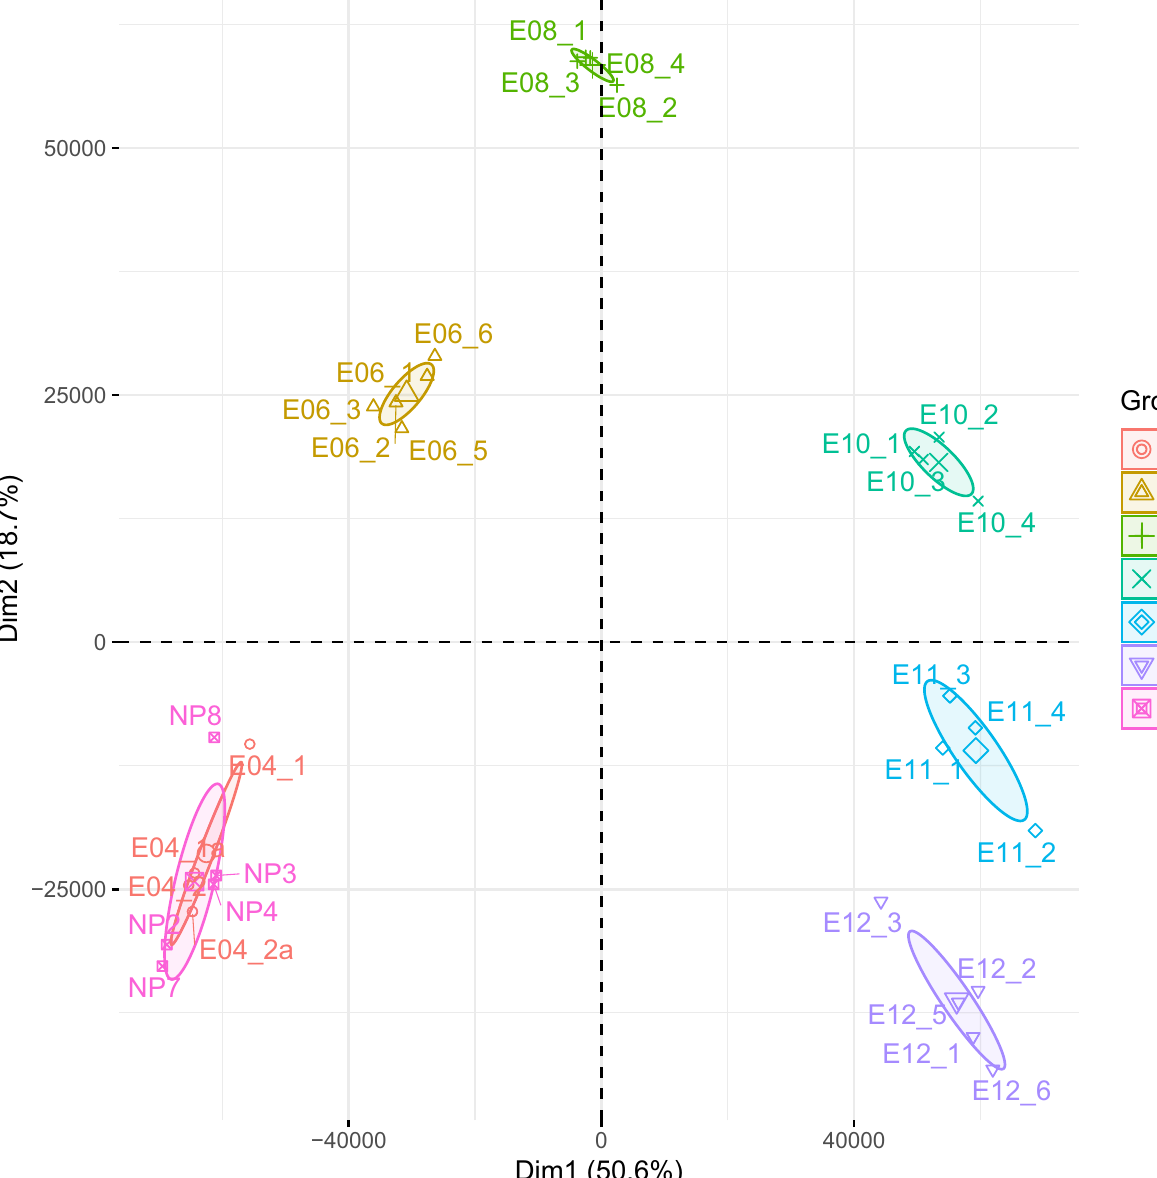
Fig 1. Principal component analysis. Transcriptome analyses were performed on non-pregnant mice (NP), and at days 4, 6, 8, 10, 11, and 12 post coitum as reported in Nehar-Belaid et al. 2016. Principal component analysis was performed on the original normalized dataset comprising 12,475 genes.